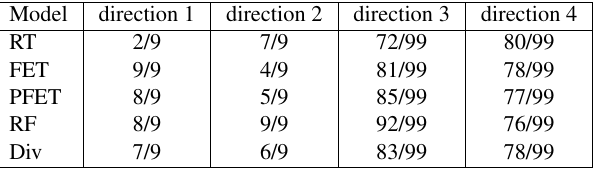
Table 1: Total performance of different distortion models